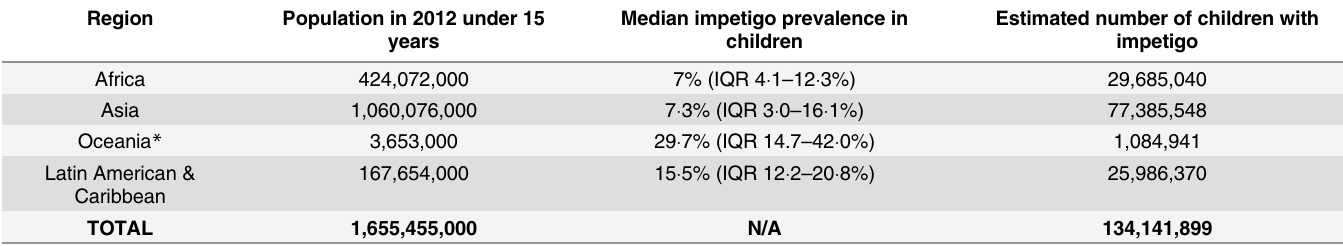
Table 3. Estimates of children with impetigo by regions of the world with available data * .